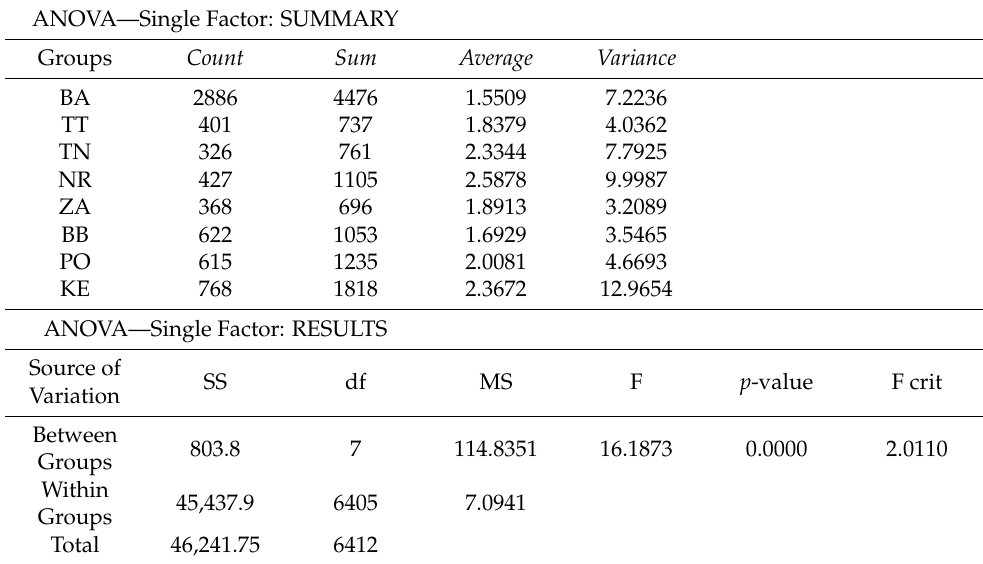
Table 4. Results of ANOVA analysis. Source: processed by